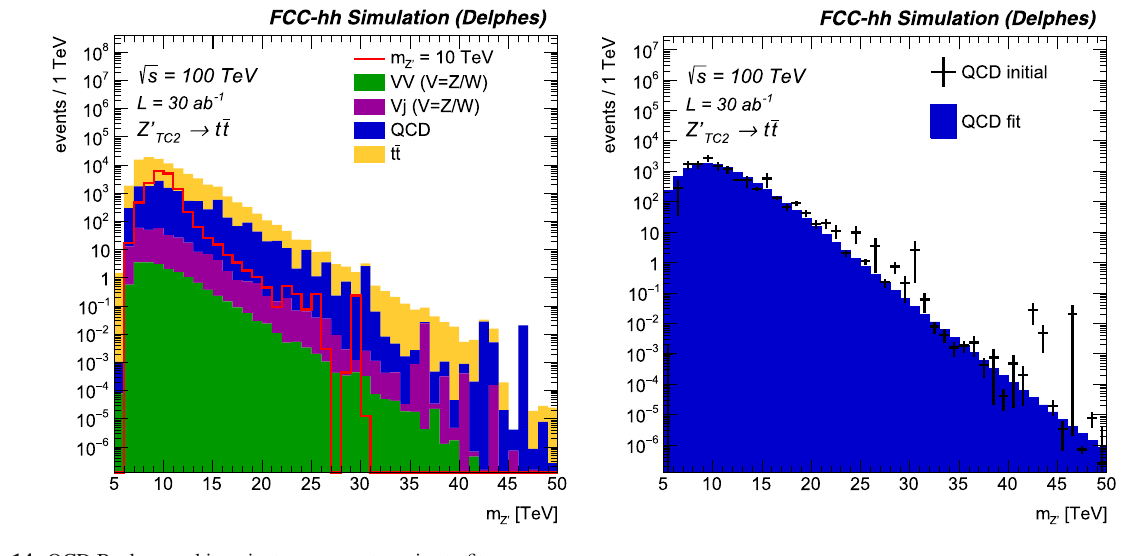
Fig. 14 QCD Background invariant mass spectra prior to